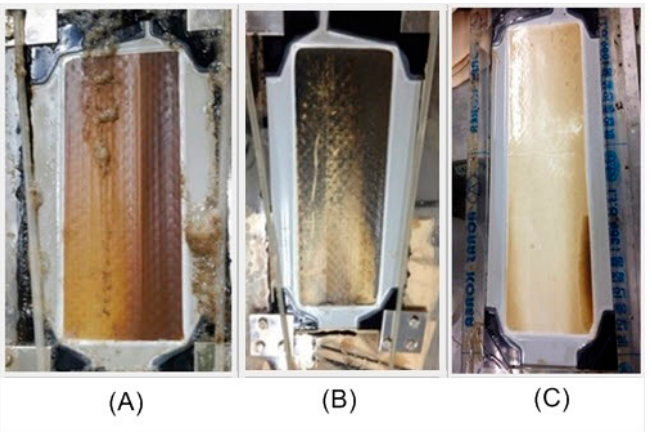
Figure 6. Images of membranes after the experimental period. ( A ) Without fouling reducer, ( B ) with 0.5% (V/V) GAC, and ( C ) with 0.5% (V/V) rubber particles. 0.5% (V/V) GAC, and ( C ) with 0.5% (V/V) rubber